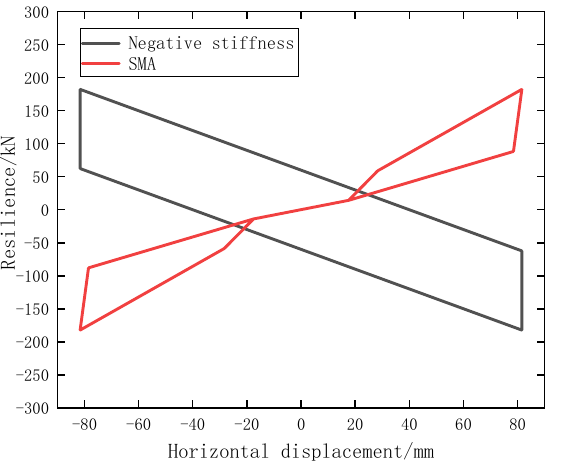
Figure 8. Restoring force-displacement comparison of SMA cable and negative stiffness system.